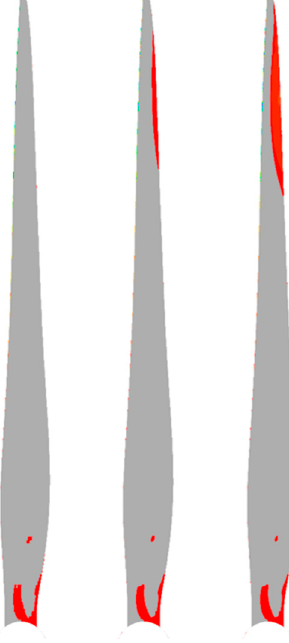
Figure 14. The 1 + cos gusts separation region (in red) over the blade suction side at a 90 ◦ azimuth angle: ( left ) ungusted case, ( center ) case with A g = 5 m / s and ( right ) case with A g = 10 m / s.